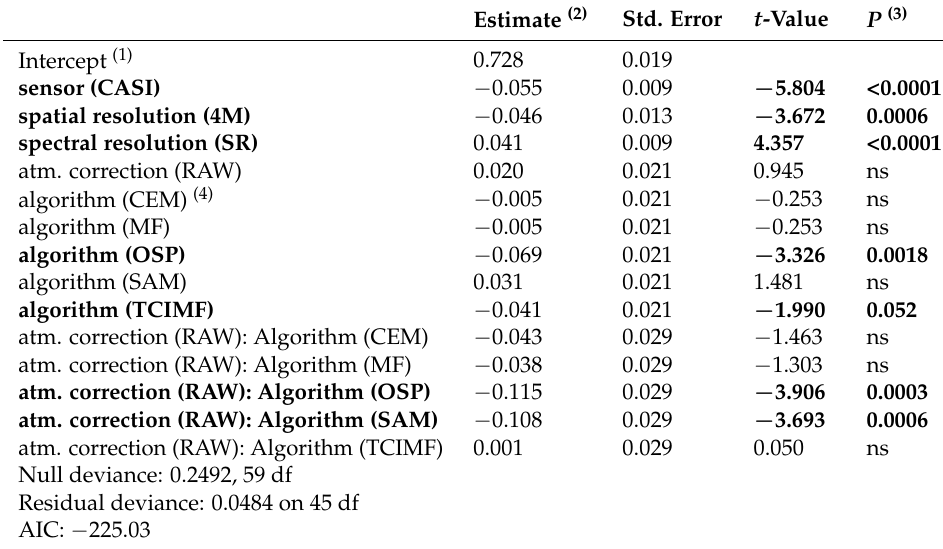
Table 6. Coefficients of GLM model fitted to Spearman rank correlation between model predictions and S. densiflora cover at the evaluation site of “Codo de la